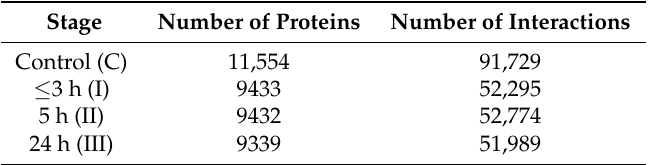
Table 1. Number of proteins and interactions in four stage-specific constructed protein-protein interaction networks (PPINs) of CE